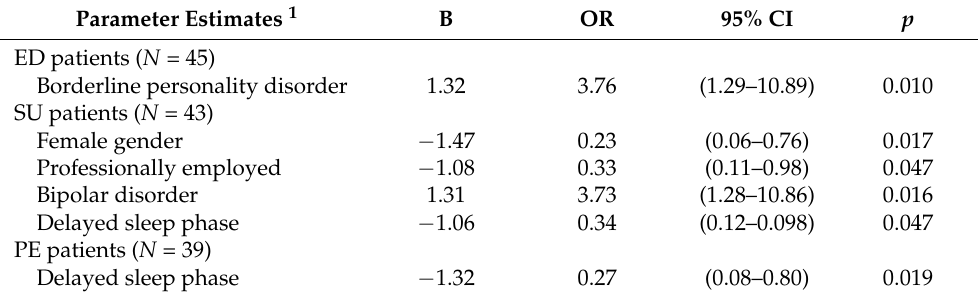
Table 3. Multinomial logistic regression of demographic and clinical characteristics compared with the factorial structure: only significant values are